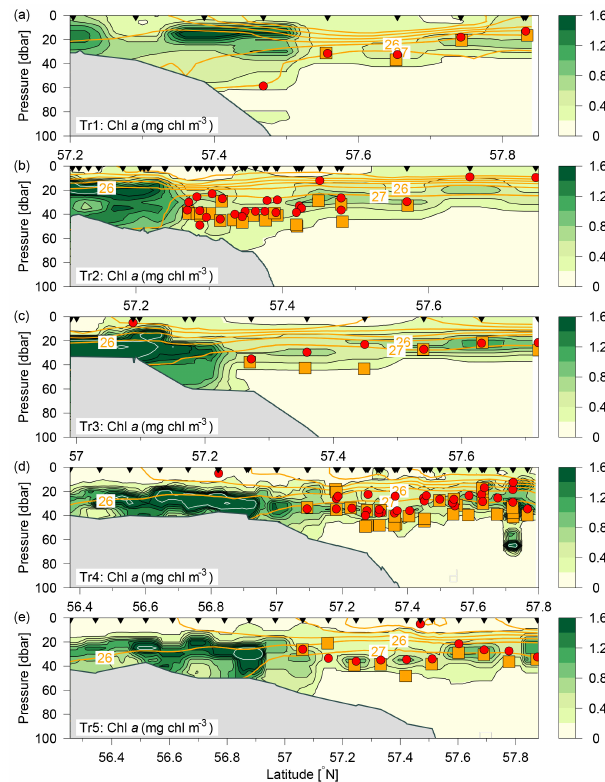
Figure 3. Distributions of chlorophyll a (mgchlm − 3 ; colours and black contours, additional white contours are shown at intervals of 2mgchlm − 3 ) along Tr1–Tr5 (a–e) . Nutricline depths (red bullets) and depths with maximum nitrate flux into the euphotic zone (or- ange squares) were calculated at each station where water samples (black triangles) and turbulence profiles were made, respectively. Contours of potential density anomalies are shown at intervals of 1kgm − 3 (orange lines). Note the different latitude-intervals in the